Question: What kind of plot is shown here?
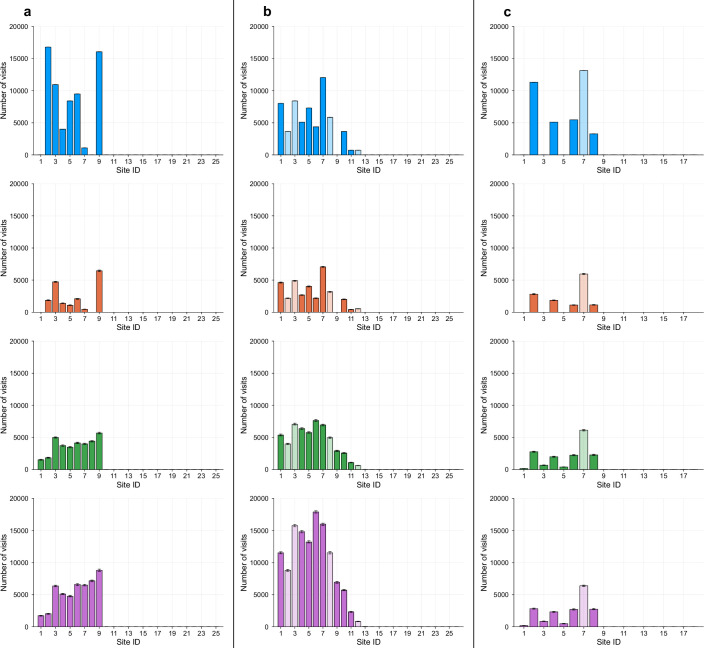
Answer: bar